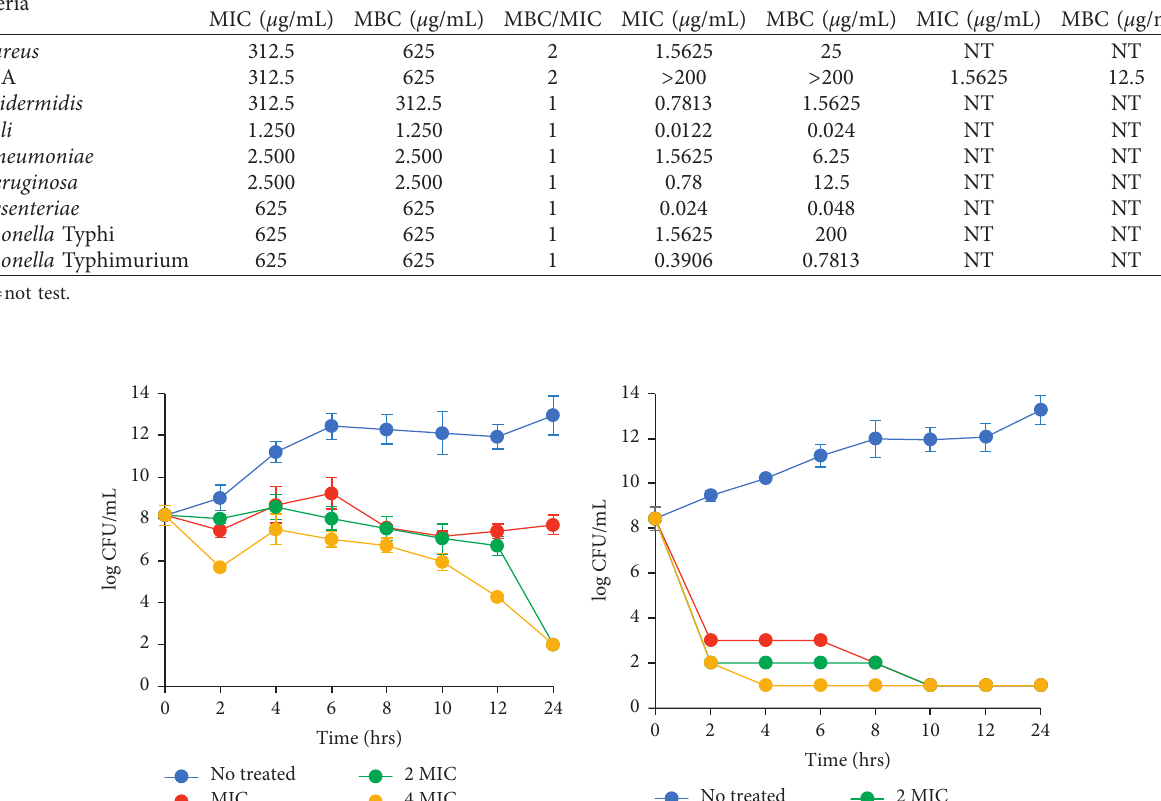
Table 1: The MIC and MBC values of C. garettiana extract, norfloxacin, and vancomycin against nine species of bacteria.